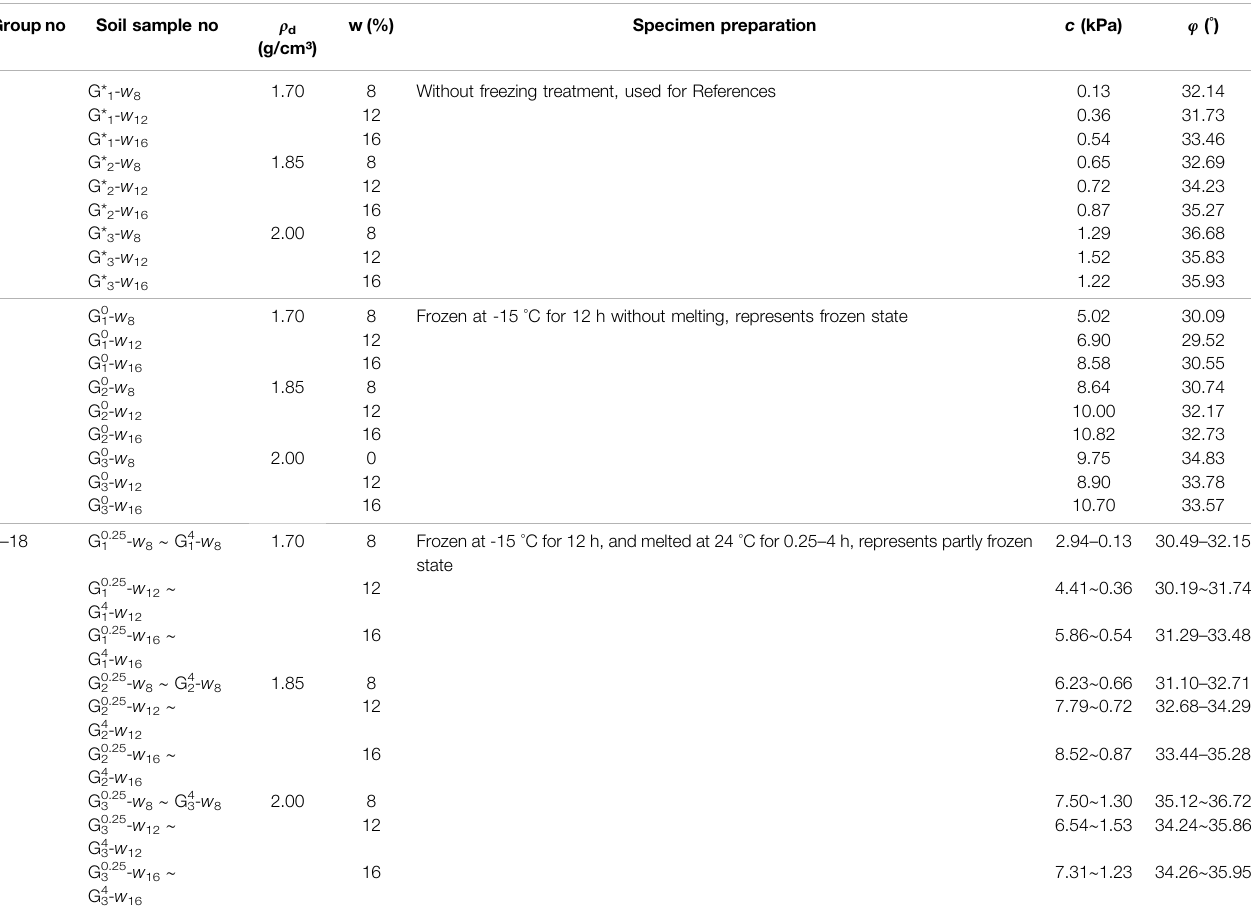
TABLE 2 | Program and result of direct shear test on glacial till specimens.